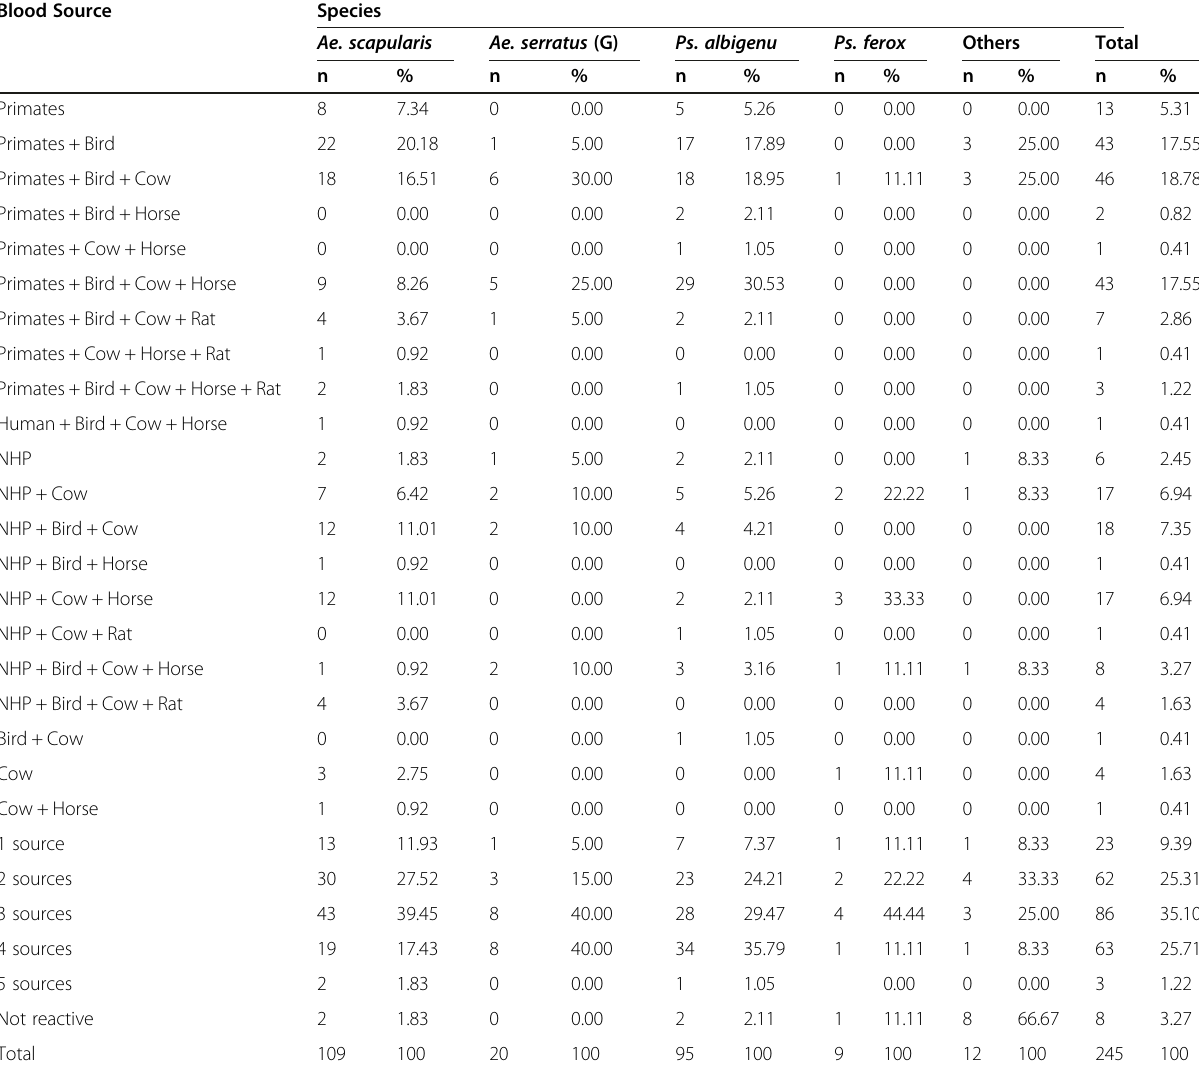
Table 2 Number of samples by combinations and numbers of types of blood source Blood Source